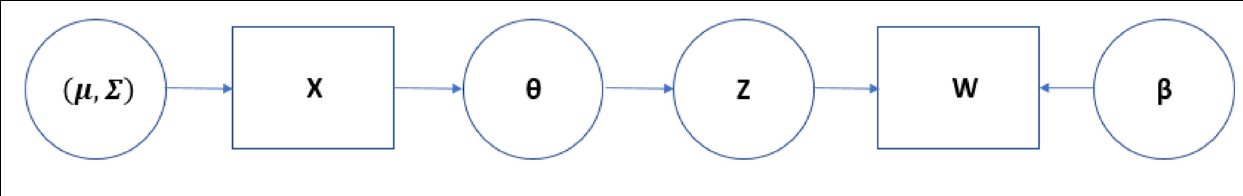
Frontiers in Psychology |